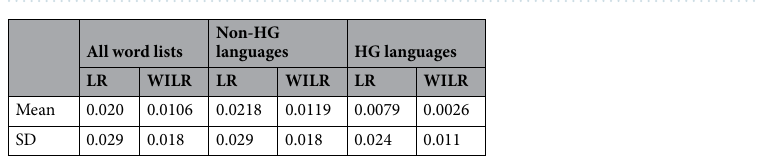
Figure 2. Locations of the 1230 word lists with labiodentals, of the 2729 in the main analysis. Brightness corresponds to LR.